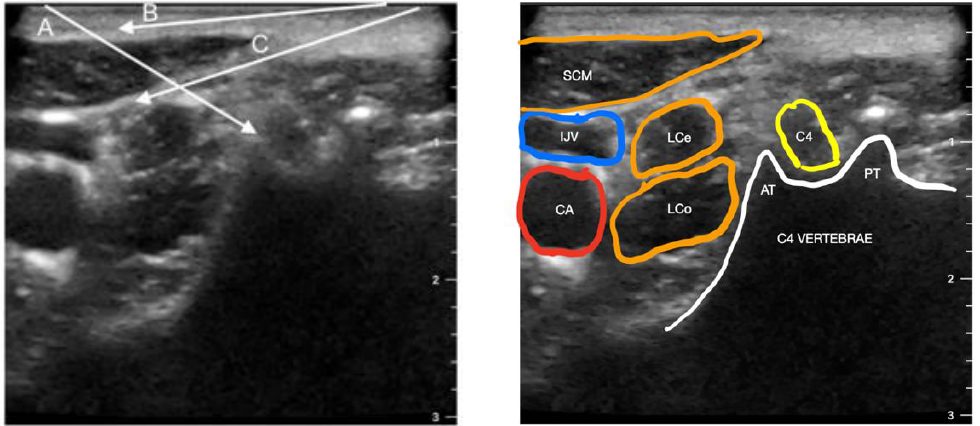
Figure 1. Transverse sonogram of the lateral cervical area at the C4 level. The arrows indicate the needle trajectories for cervical plexus block: A—deep; B—superficial; C—intermediate. SCM—sternocleidomastoid muscle; IJV—internal jugular vein; CA—carotid artery; LCe—longus cervicis muscle; LCa—longus colli muscle; AT—anterior tubercle of transverse process; PT—posterior tubercle of transverse